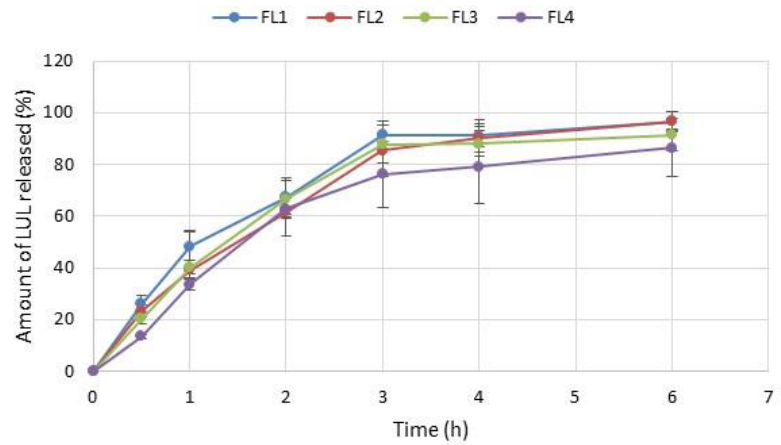
Figure 9. In vitro LUL dissolution studies in SVF pH 4.2 from formulations FL1 – FL4 (mean ± SD, n = 3).